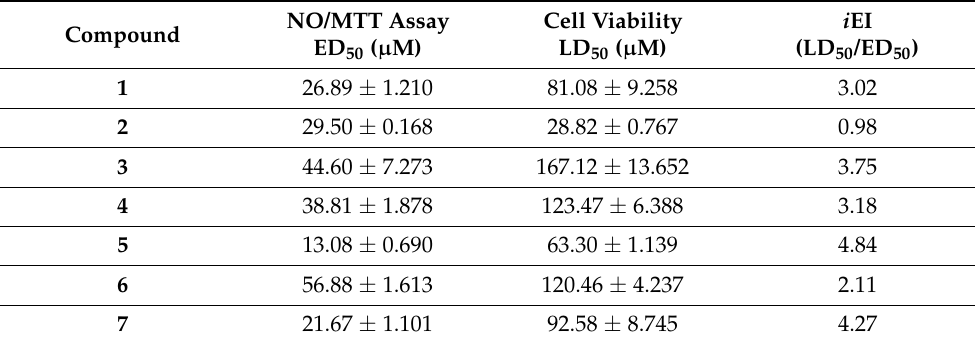
Table 2. Inhibitory effects of resveratrol 1 and its analogues 2 – 7 on NO